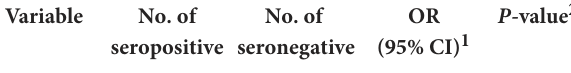
TABLE 2 Frequency distribution and the ouput of univariable mixed-effects logistic regression models evaluating the association between each risk factor of interest and seropositivity to T. annulata in 350 large ruminants raised under the smallholder–production system in five districts of the Sharkia governorate, Egypt.